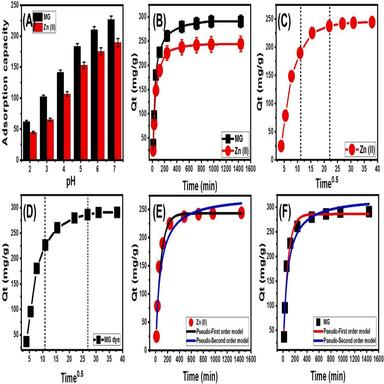
Changes in the adsorption capacities of Mg-doped hydroxyapatite nanofibers (Mg.HAPNFs) for Zn2+ ions and MG dye with (A) pH and (B) time. Intraparticle diffusion curve for the adsorption of (C) Zn2+ ions and (D) malachite green (MG) dye onto Mg.HAPNFs. Pseudo-first and pseudo-second order kinetic models used to fit the adsorption capacities of Mg.HAPNFs for (E) Zn2+ ions and (F) MG dye.